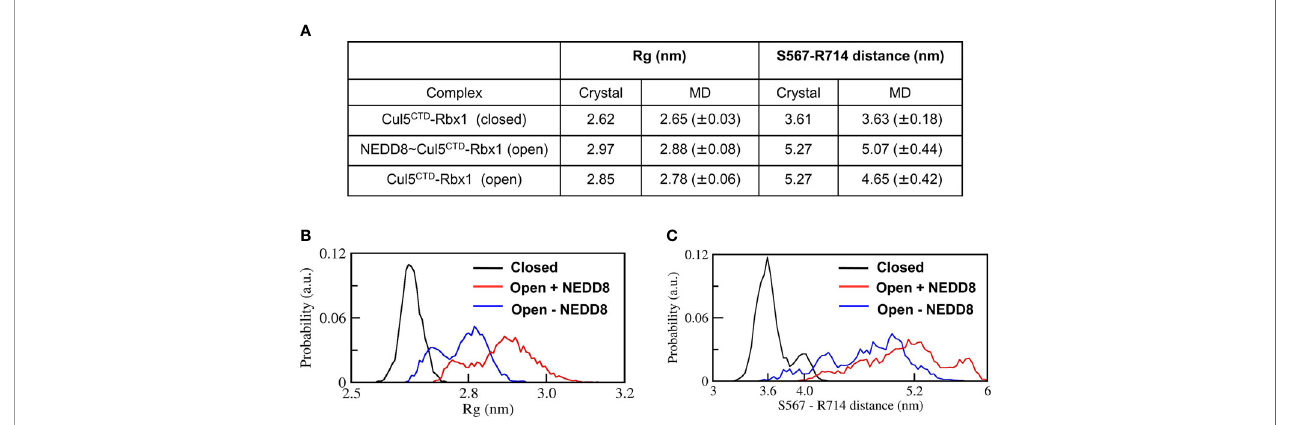
FIGURE 3 | Dynamic ensembles of Cul5 CTD closed, and open states were observed from simulations. (A) Radius of gyration for Cul5 CTD -Rbx1 variants and S567- R714 separation in Cul5 CTD calculated from MD simulations. Mean ± std deviation for each variant is calculated over eight independent MD trajectories performed for 200 ns. (B) Probability distributions for the radius of gyration (Rg) of closed/open states of Cul5 CTD -Rbx1 calculated from the 1.6 m s macro trajectory for each state. The macro trajectory was obtained by combining eight independent 200 ns runs. (C) Probability distribution of S567-R714 distance in Cul5 CTD calculated from the 1.6 m s macro trajectory for each state.